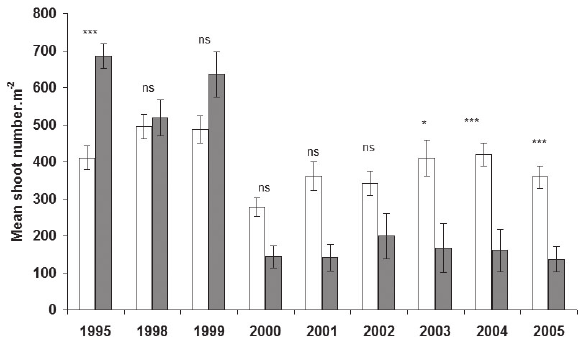
Fig . 2. – Mean shoot density of Posidonia oceanica, from 1995 to 2005, at the invaded site of Cap Martin (grey bars) and at the control site of Cap d’antibes (white bars). error bars represent ± se. Multi- ple comparison test invaded vs. control site year per year - lsd test: